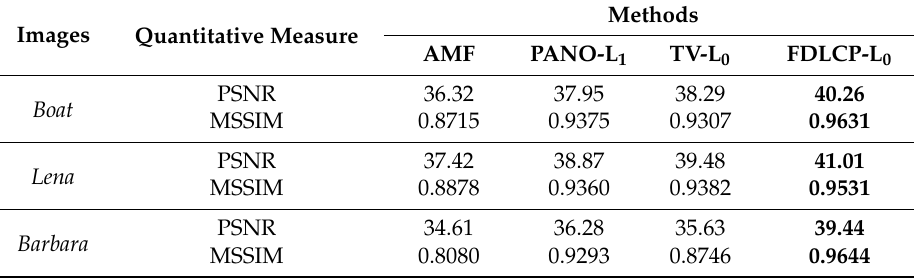
Table 1. Quantitative measures at the salt and pepper impulse noise level of